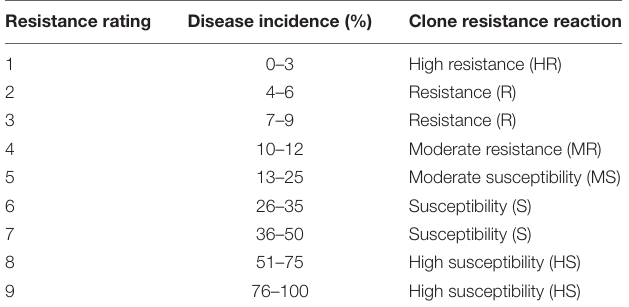
TABLE 1 | Smut resistant ratings of sugarcane varieties GT21 and ROC25 and the